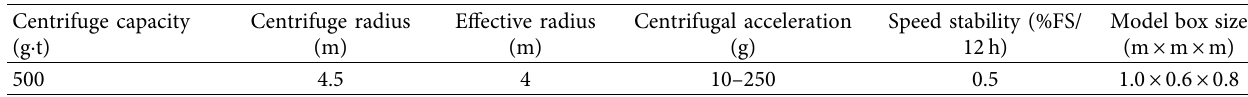
Table 2: Main technical indexes of the geotechnical centrifuge.